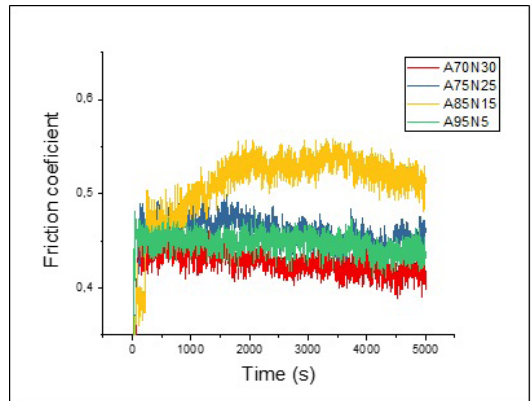
Figure 6. Evolution of the coefficient of friction as a function of time for different Al